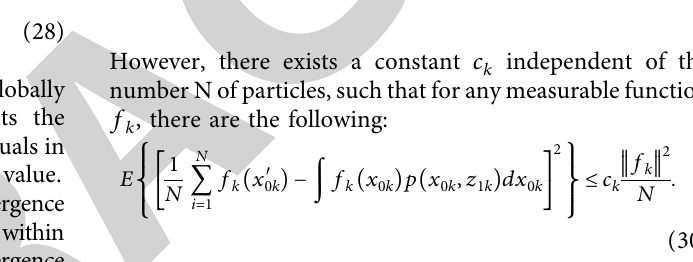
Figure 1: Convergence of parameter estimation of the E-CELL model under Gaussian